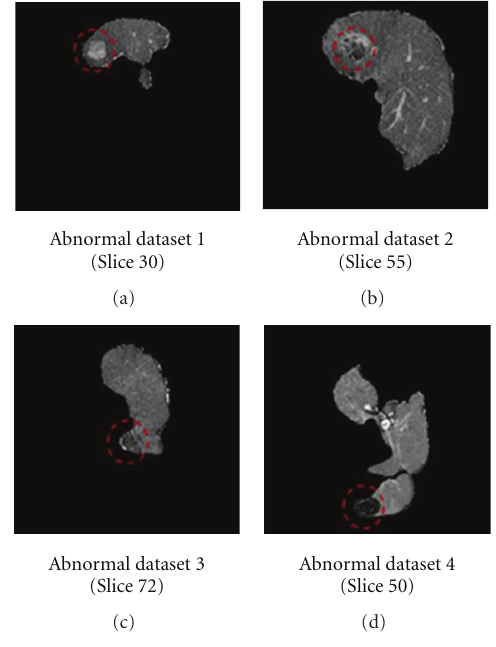
Figure 3: Slices of abnormal